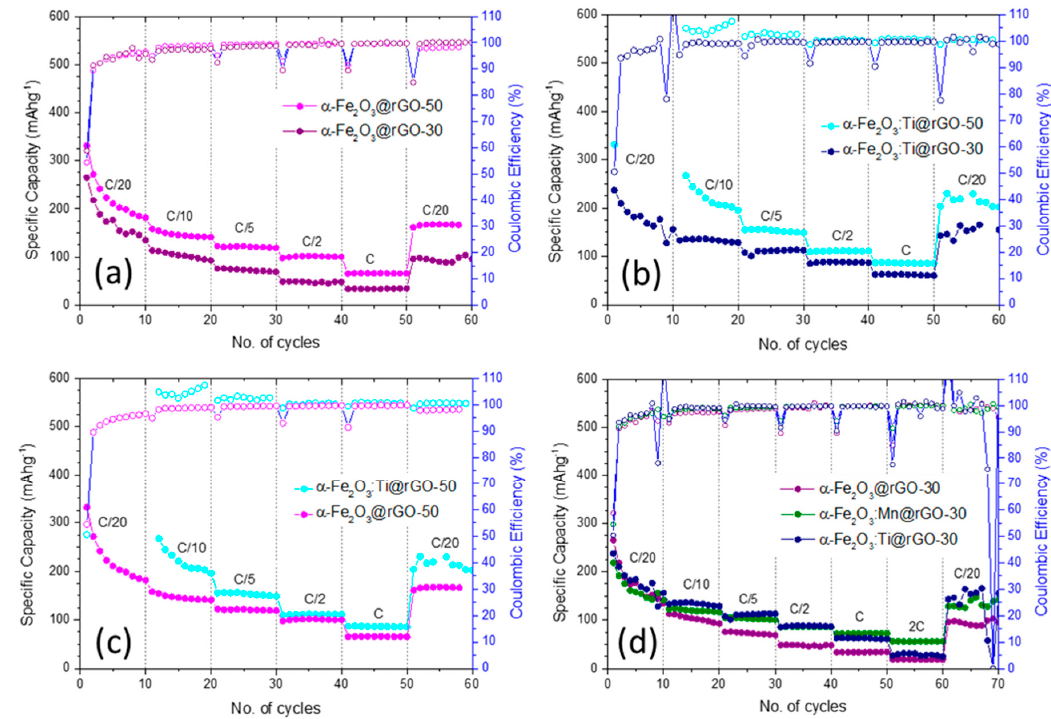
Figure 4. Effect of ( a , b ) the rGO amount and ( c , d ) the doping on the rate capabilities of all the